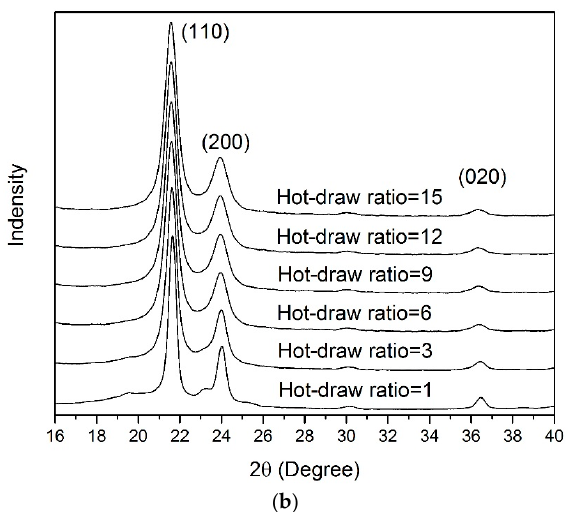
Figure 10. WAXD patterns of fiber samples with different hot-draw ratios: ( a ) U/H blend fiber samples; and ( b ) U fiber samples.